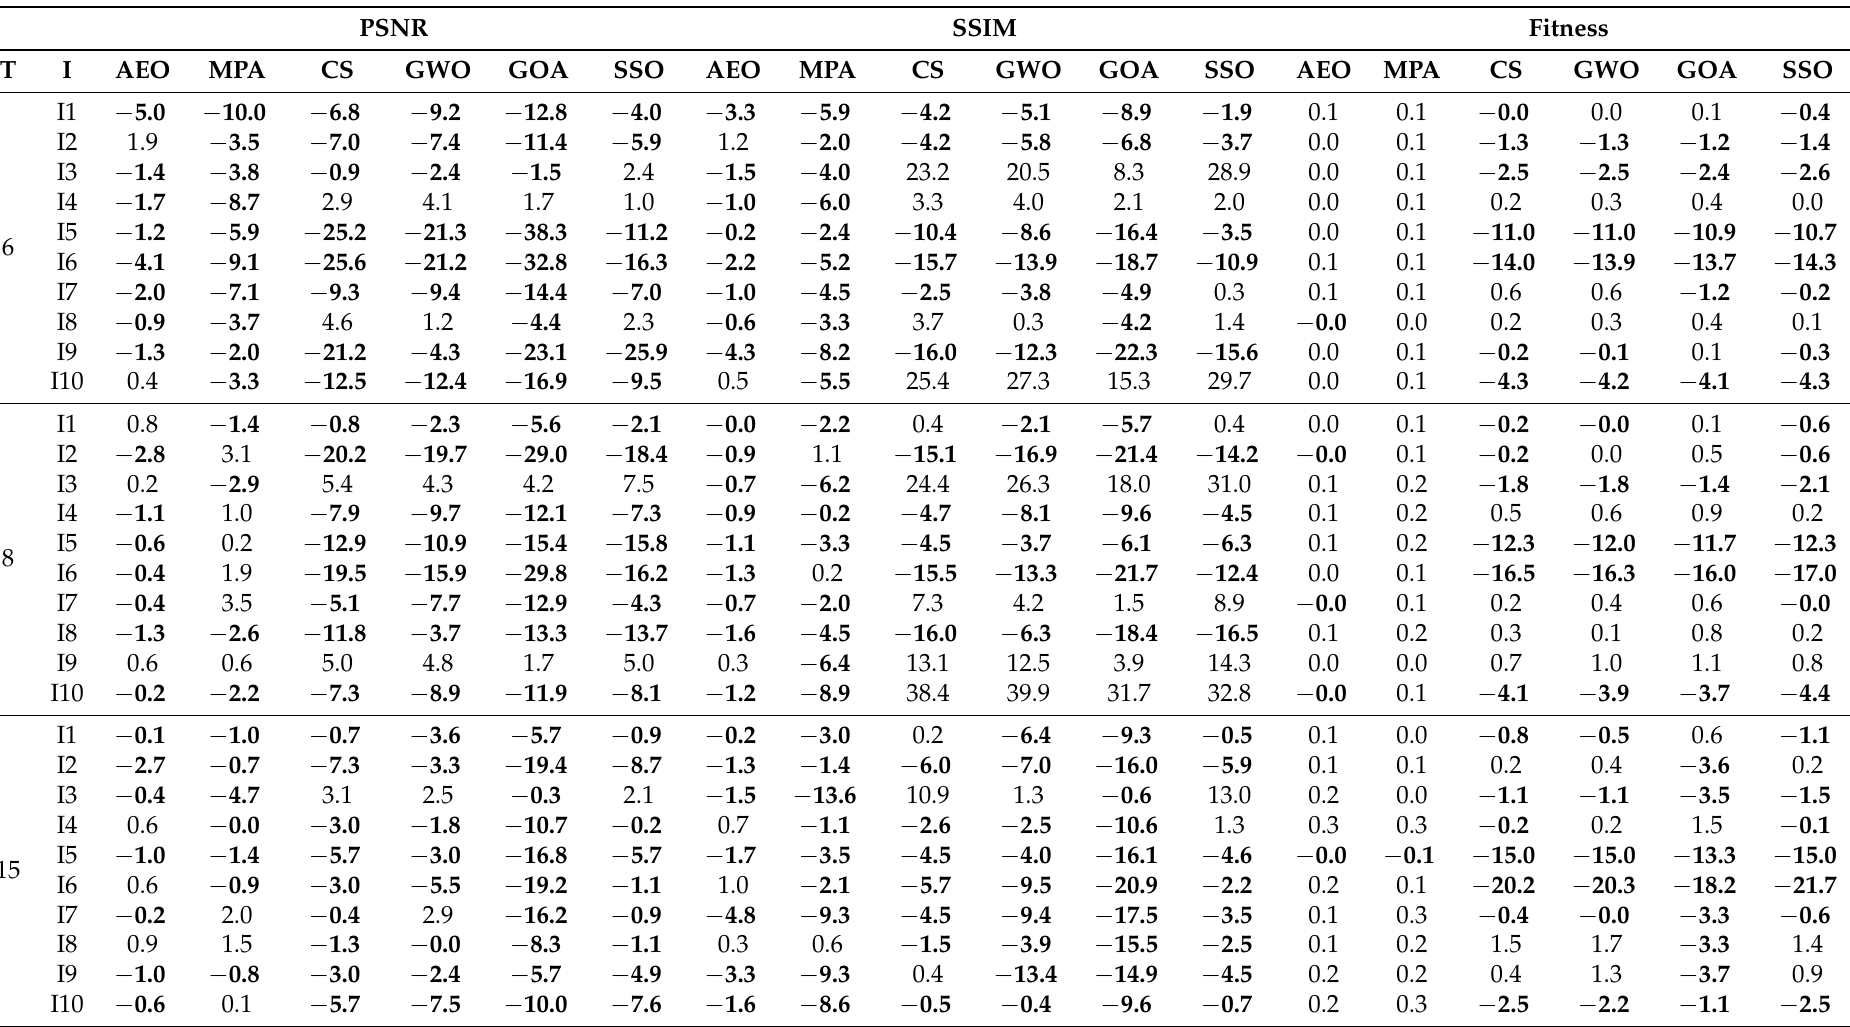
Table 4. Improvement ratio for developed method with other methods (bold means the best